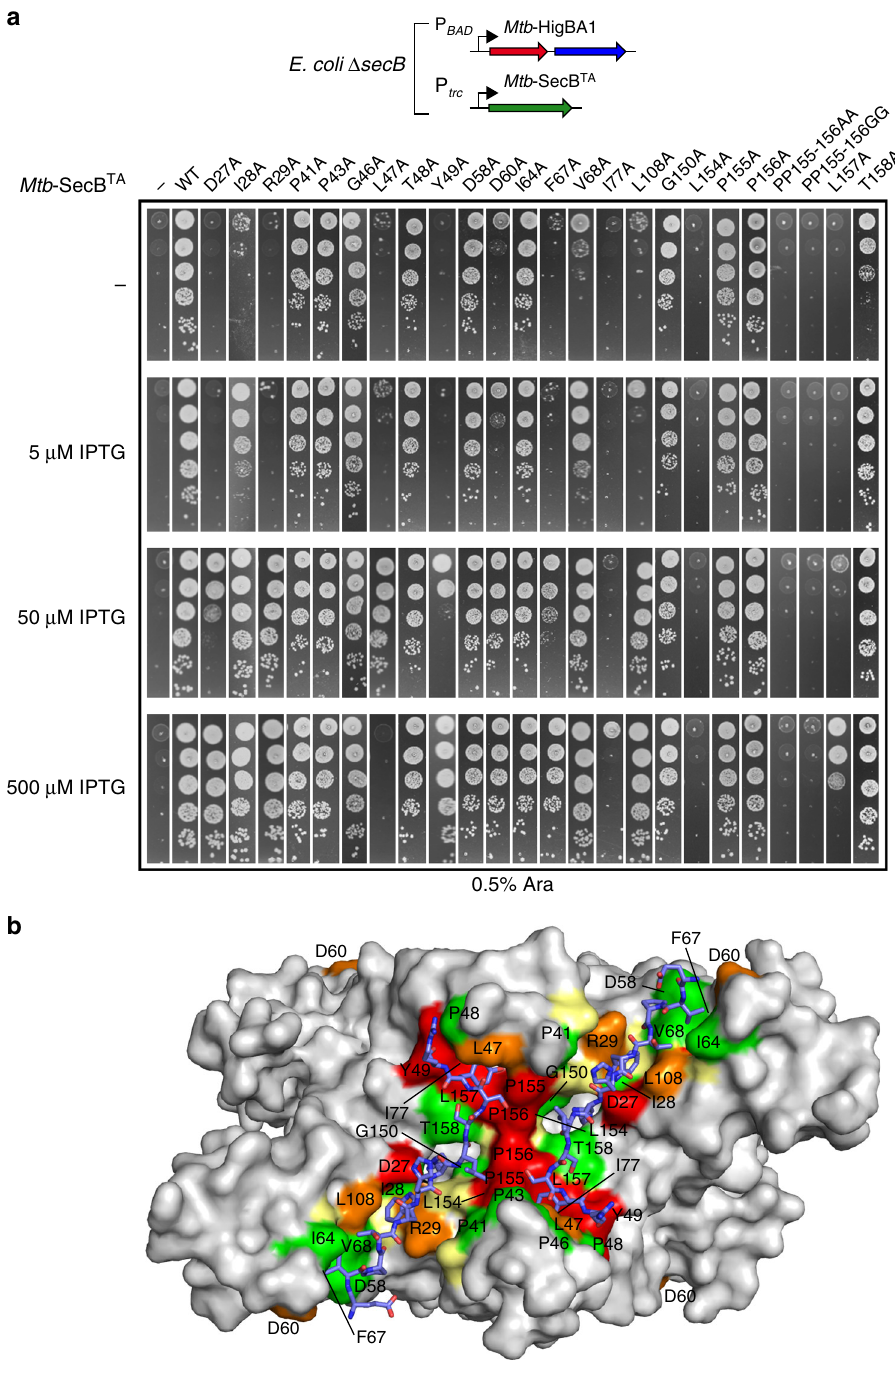
Fig. 3 In vivo functions of TA-directed Mtb -SecB TA mutants. a Suppression of Mtb -HigBA1 toxicity by Mtb -SecB TA mutants. E . coli W3110 Δ secB transformants containing the p29SEN-based Mtb -SecB TA chaperone mutants and pK6- Mtb -HigBA1 were grown to mid-log phase, serially diluted and spotted on LB ampicillin kanamycin agar plates with or without IPTG (to express Mtb -SecB TA ) and arabinose (to express Mtb -HigBA1) as indicated. Plates were incubated overnight at 37 °C. Spot tests have been performed in triplicates. b Localization of the mutations on the Mtb -SecB TA /ChAD structure. The molecular surface of the tetramer is represented in light gray. Color coding of interacting residues is the same as in Fig. 1b. Residues that were not tested (i.e., Ala residues and Y146) are colored in pale